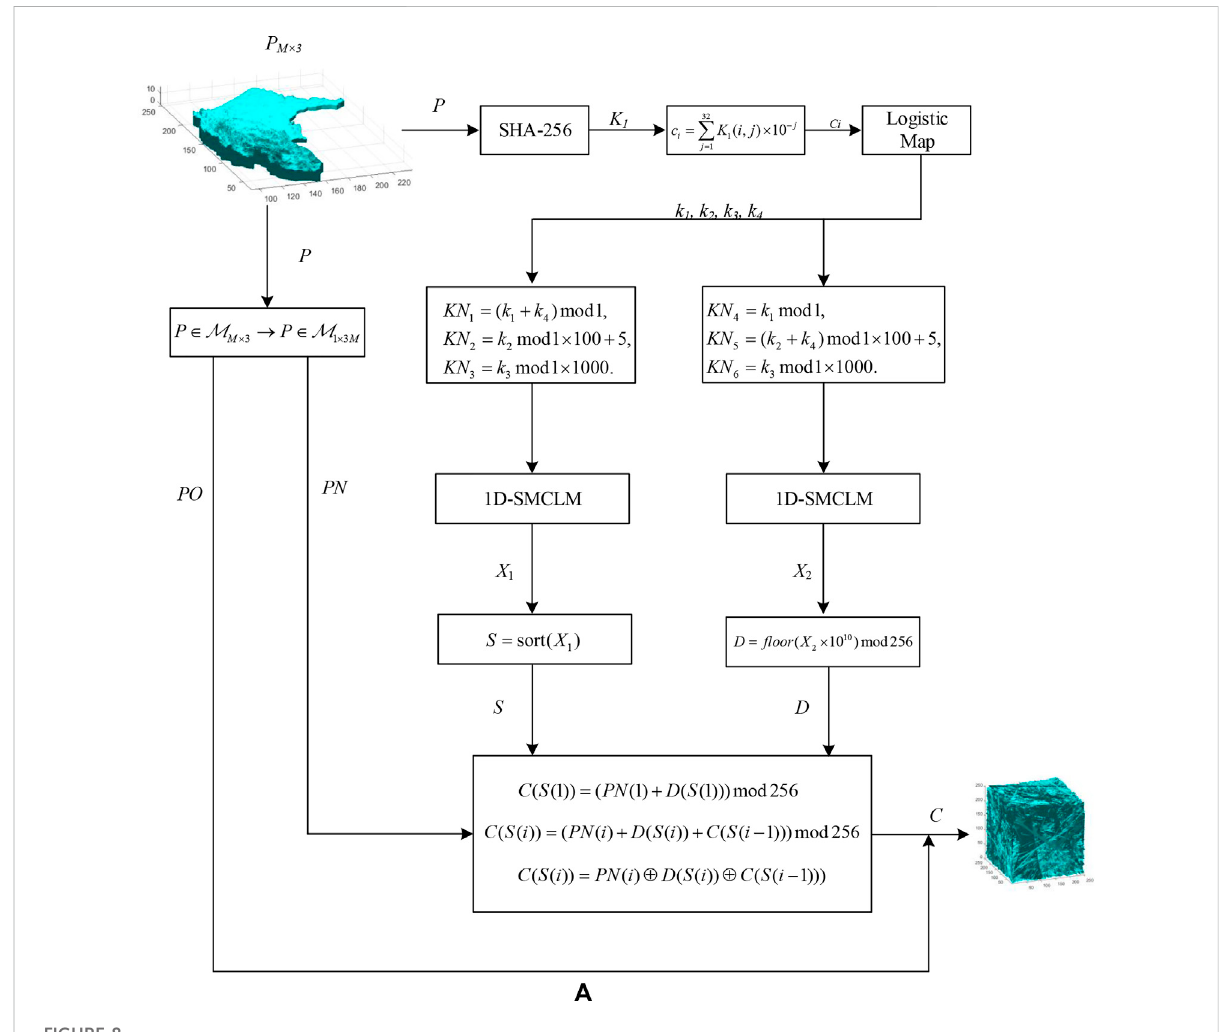
FIGURE 8 Structure diagram of SMCLM-3ME.